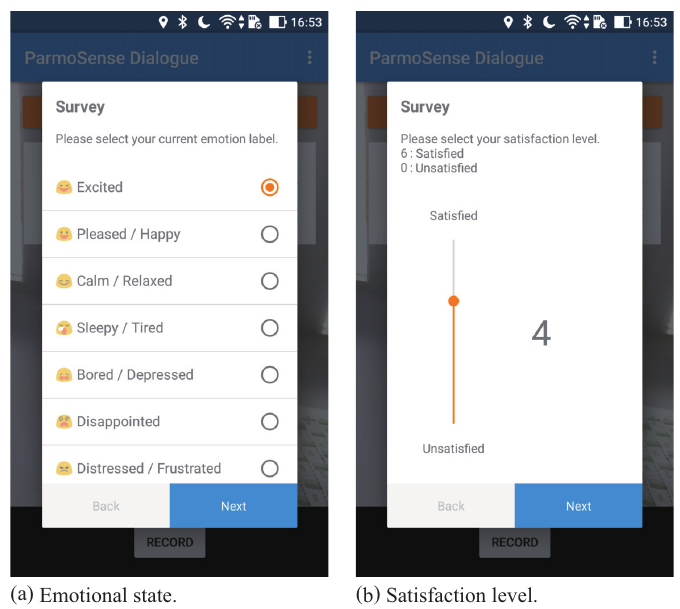
Figure 3. Smartphone application for collecting labels from tourists.